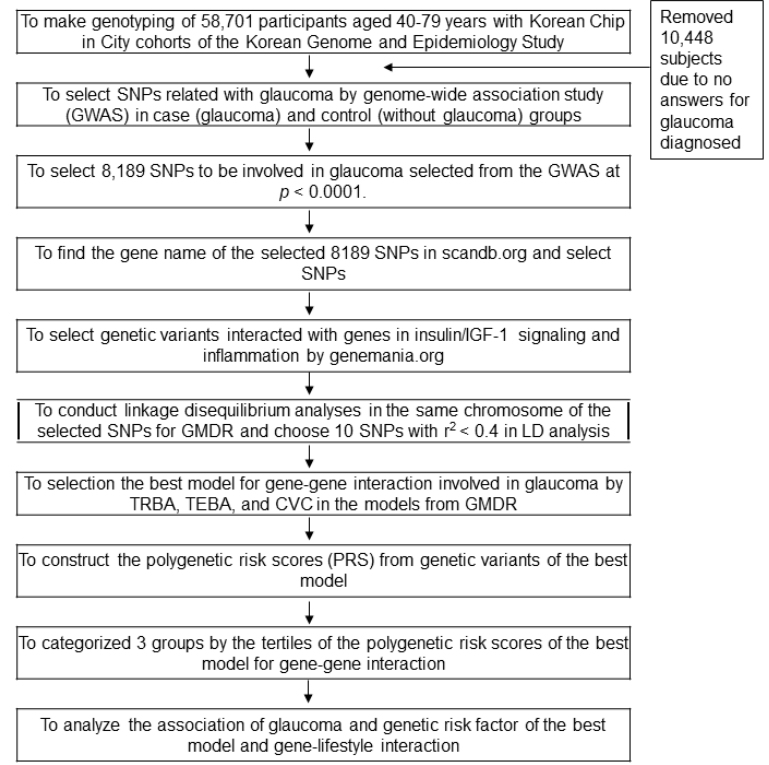
Figure 1. The flow chart to make polygenetic-risk scores to influence glaucoma risk. GMDR, generalized multifactor dimensionality reduction; TRBA, trained balanced accuracy; TEBA, testing balanced accuracy; CVC, cross-validation consistency.